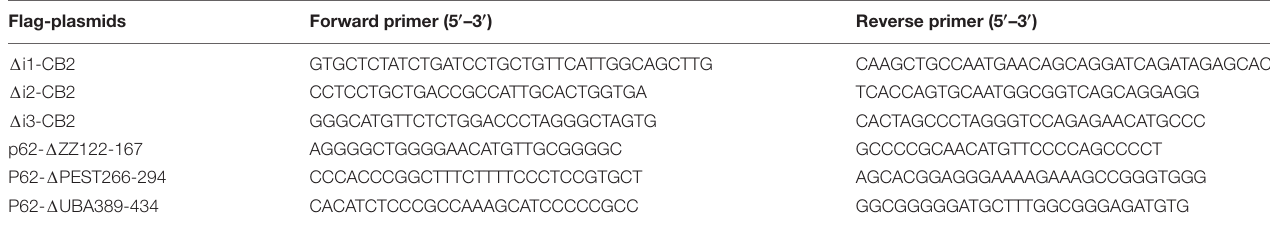
TABLE 1 | Sequences of primer pairs used for the generation of CB2 deletion constructs of intracellular loops ( (cid:49) i) and p62 deletion constructs. Flag-plasmids Forward primer (5 (cid:48) –3 (cid:48) ) Reverse primer (5 (cid:48) –3 (cid:48)